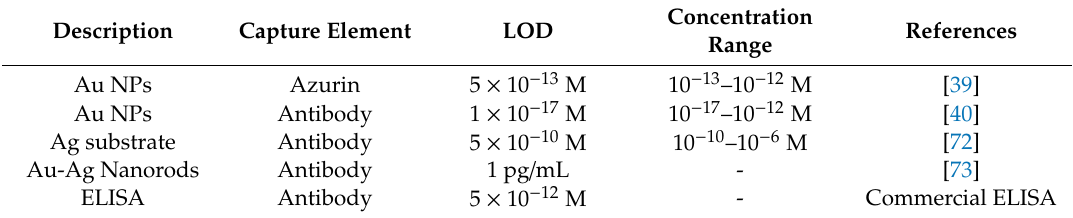
Table 1. SERS-based biosensing methods for detection of